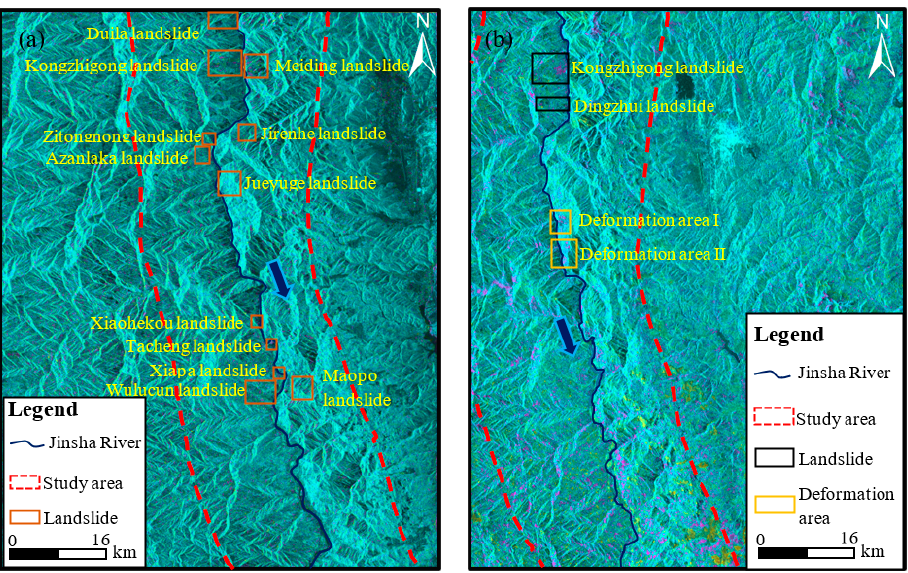
Figure 3. ( a ) Distribution of potential landslides interpreted from ALOS-2 data and ( b ) distribution of potential landslides interpreted from Sentinel-1A data.